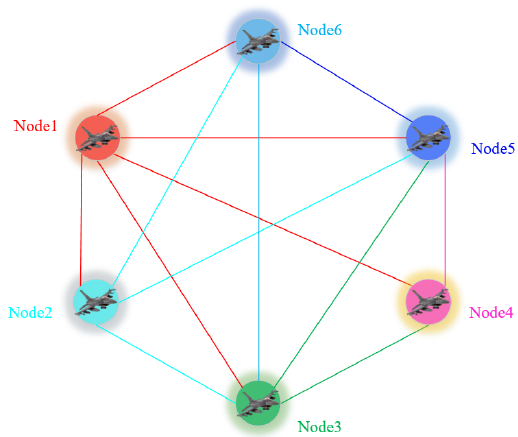
Figure 3. A distributed mesh data link network structure.